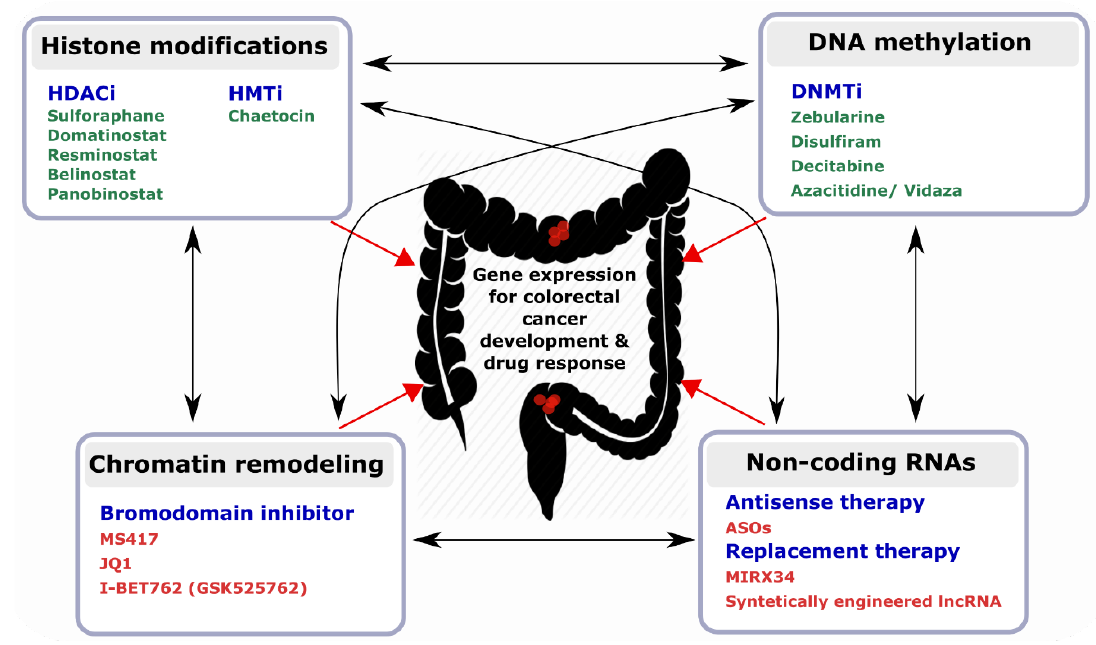
Figure 3. Representative drugs targeting epigenetic modifiers. Green colour represents FDA-approved drugs and red colour represents other potential drugs for targeting epigenetics modifiers. Black arrows indicate the reciprocal interplay of epigenetic events with ncRNAs and red arrows represent their effects on the CRC genome and transcriptome.